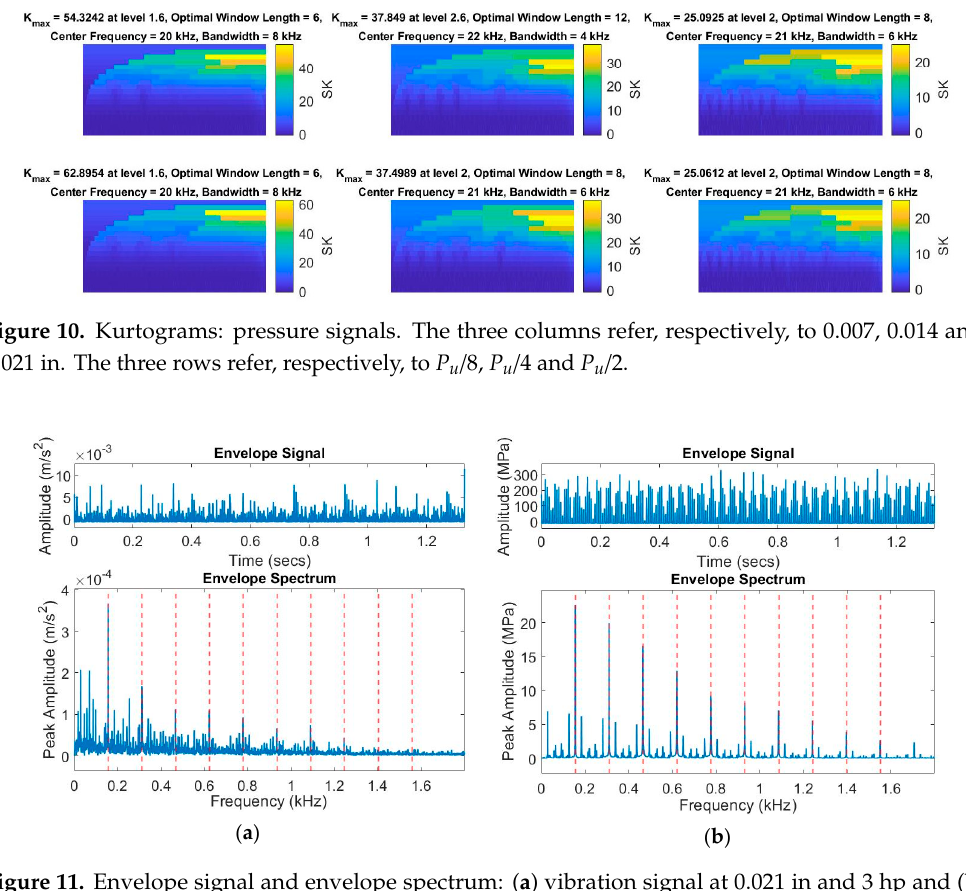
Figure 11. Envelope signal and envelope spectrum: ( a ) vibration signal at 0.021 in and 3 hp and ( b ) pressure signal at 0.021 in and P u /2. In red, the first ten x BPFI harmonics. BPFI : Ball Passing Frequency on the Inner race.